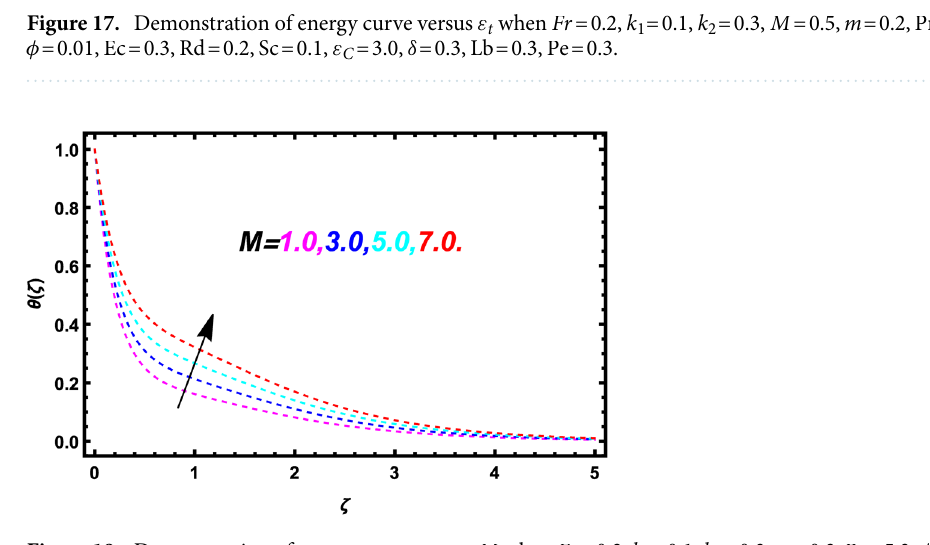
Figure 18. Demonstration of energy curve versus M when Fr = 0.2, k 1 = 0.1, k 2 = 0.3, m = 0.2, Pr = 5.3, φ = 0.01, Ec = 0.3, ε Rd = 0.2, Sc = 0.1, ε Lb = 0.3, Pe = t = 3.0, C = 3.0, δ = 0.3,